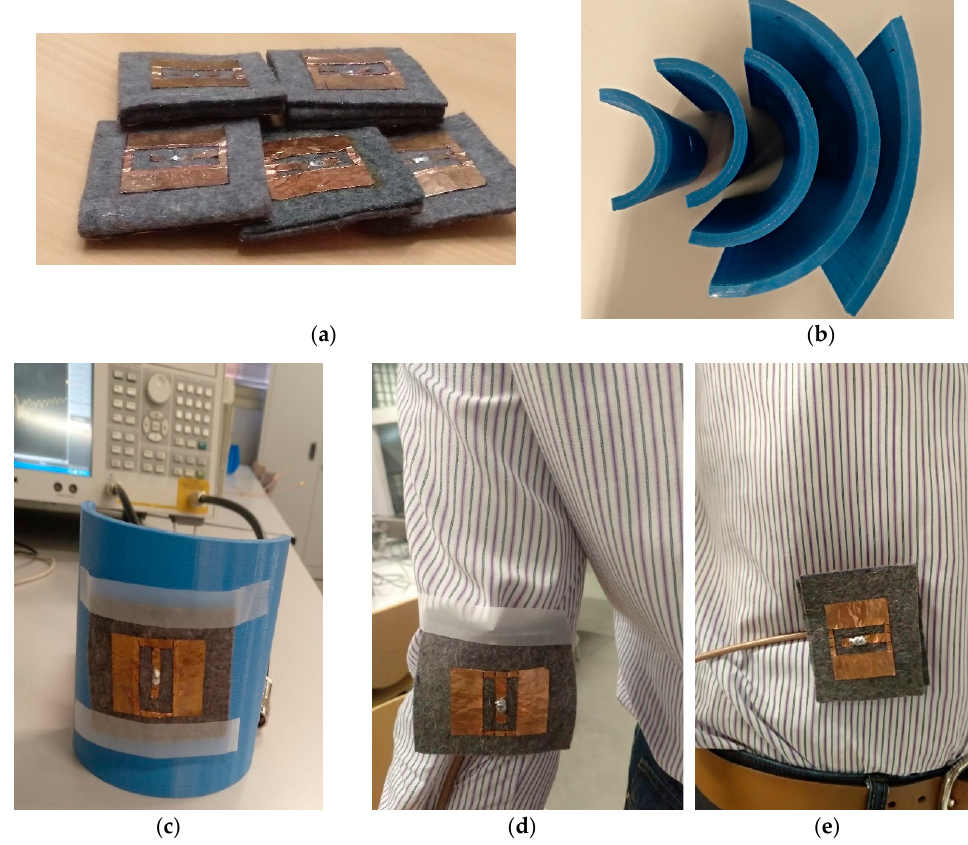
Figure 10. Measurement setup used to test the bend effect on textile antennas. ( a ) Antenna prototypes with different felt thicknesses, ( b ) three-dimensional (3D) bending structures, ( c ) Network Analyzer and ( d ) and ( e ) Arm and waist measurements.